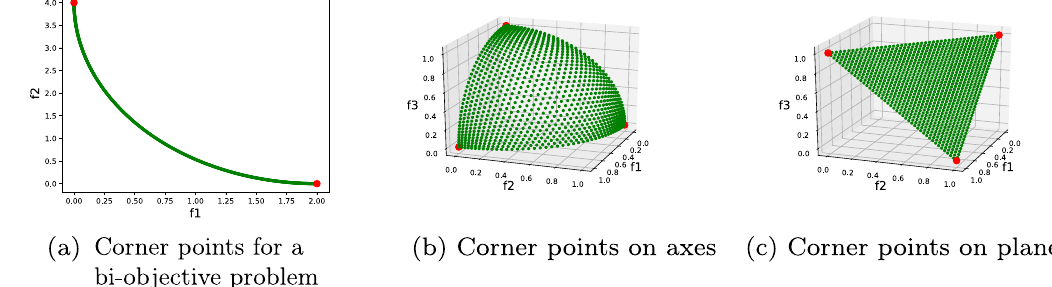
Fig. 2 Some examples of corner points (shown in red)